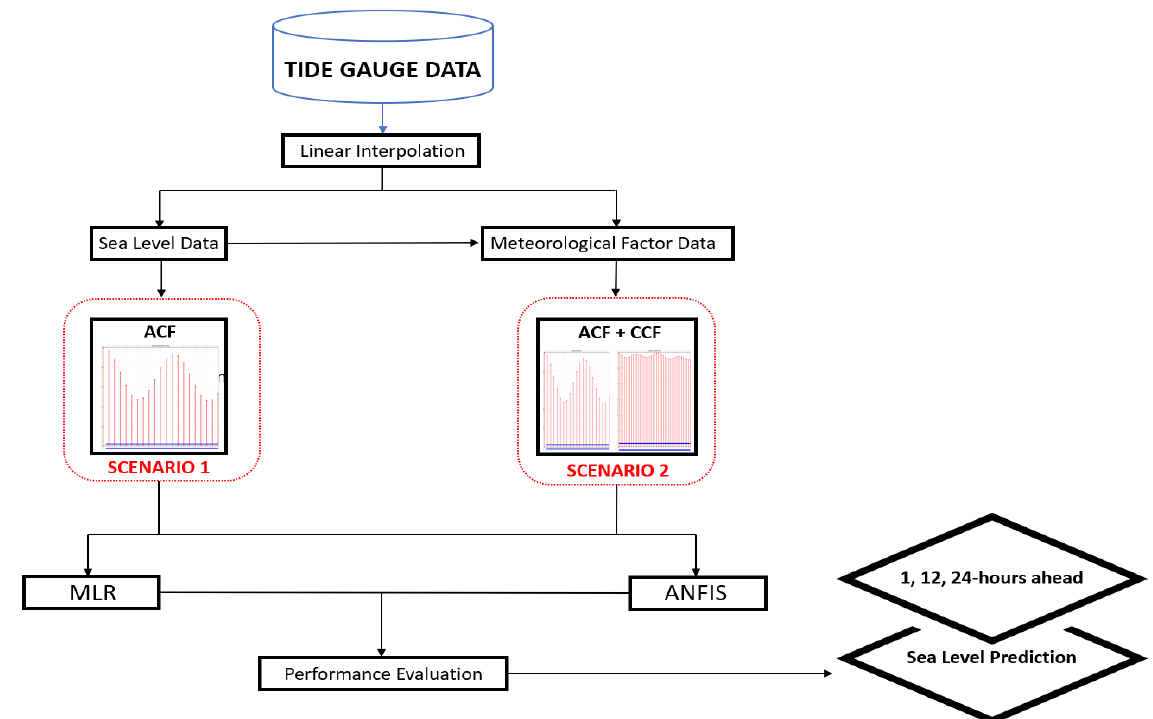
Figure 3. Flow chart for sea level prediction methodology.